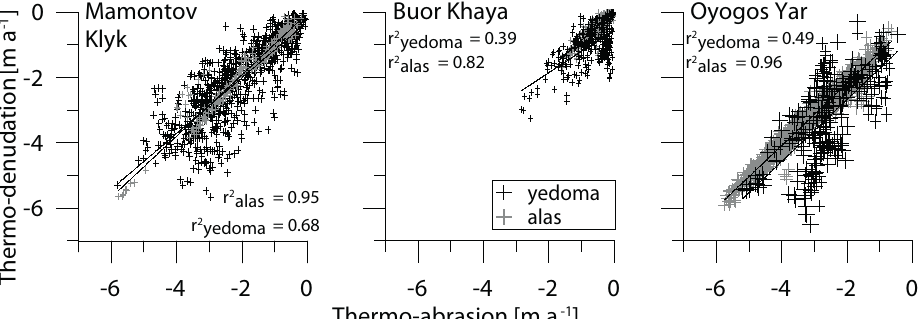
Fig. 5. Mean annual thermo-denudation (TD) vs. thermo-abrasion (TA) rates, divided into alas and yedoma coastline types by study sites. Cross symbols are built of error bars of TD and TA rate uncertainty (see Sect. 3.5), corresponding to the TD and TA axis, respectively.